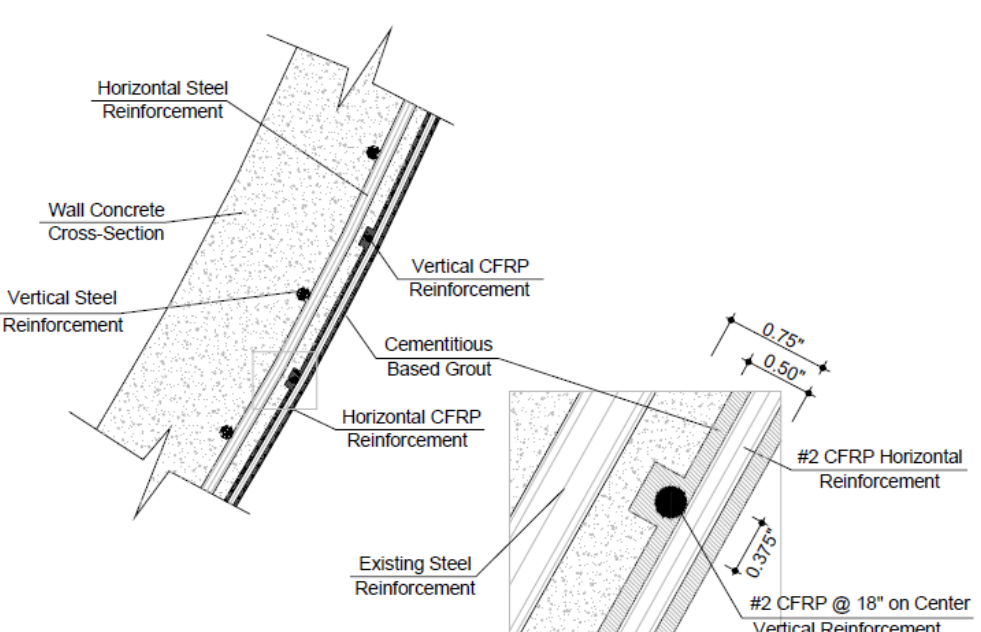
Figure 7. Concrete wall cross-section illustrating the location of near-surface mounted FRP bars and traditional steel reinforcements [82]